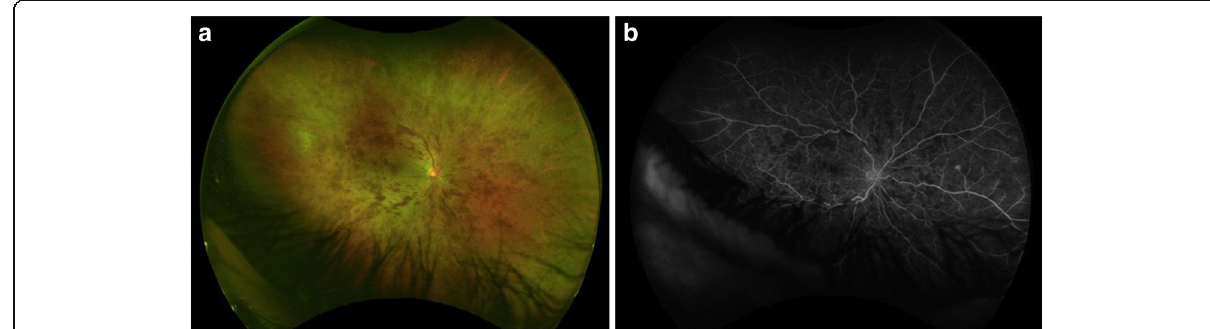
Fig. 1 a Color fundus photograph OD showing a hyperemic optic nerve head, macular thickening, vascular tortuosity, and diffuse intraretinal hemorrhages. b Late-phase fluorescein angiogram OD demonstrating vascular tortuosity and vessel wall staining without capillary non-perfusion